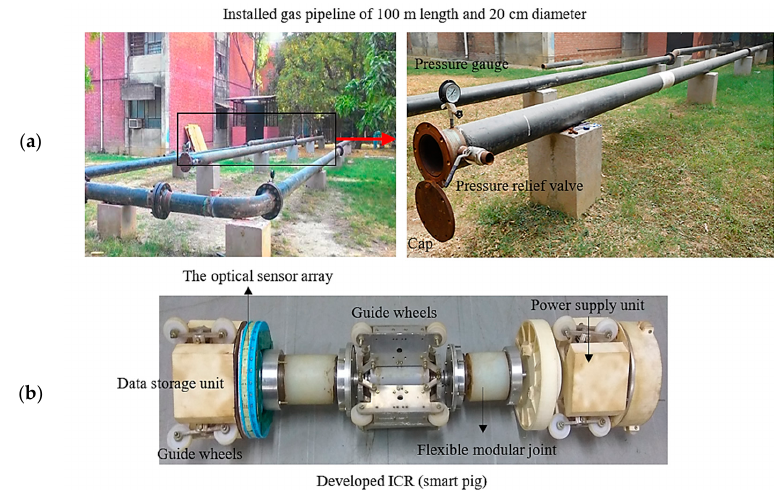
Figure 15. Images of the field test for in-line application; ( a ) gas transporting pipeline, ( b ) the designed PIG.